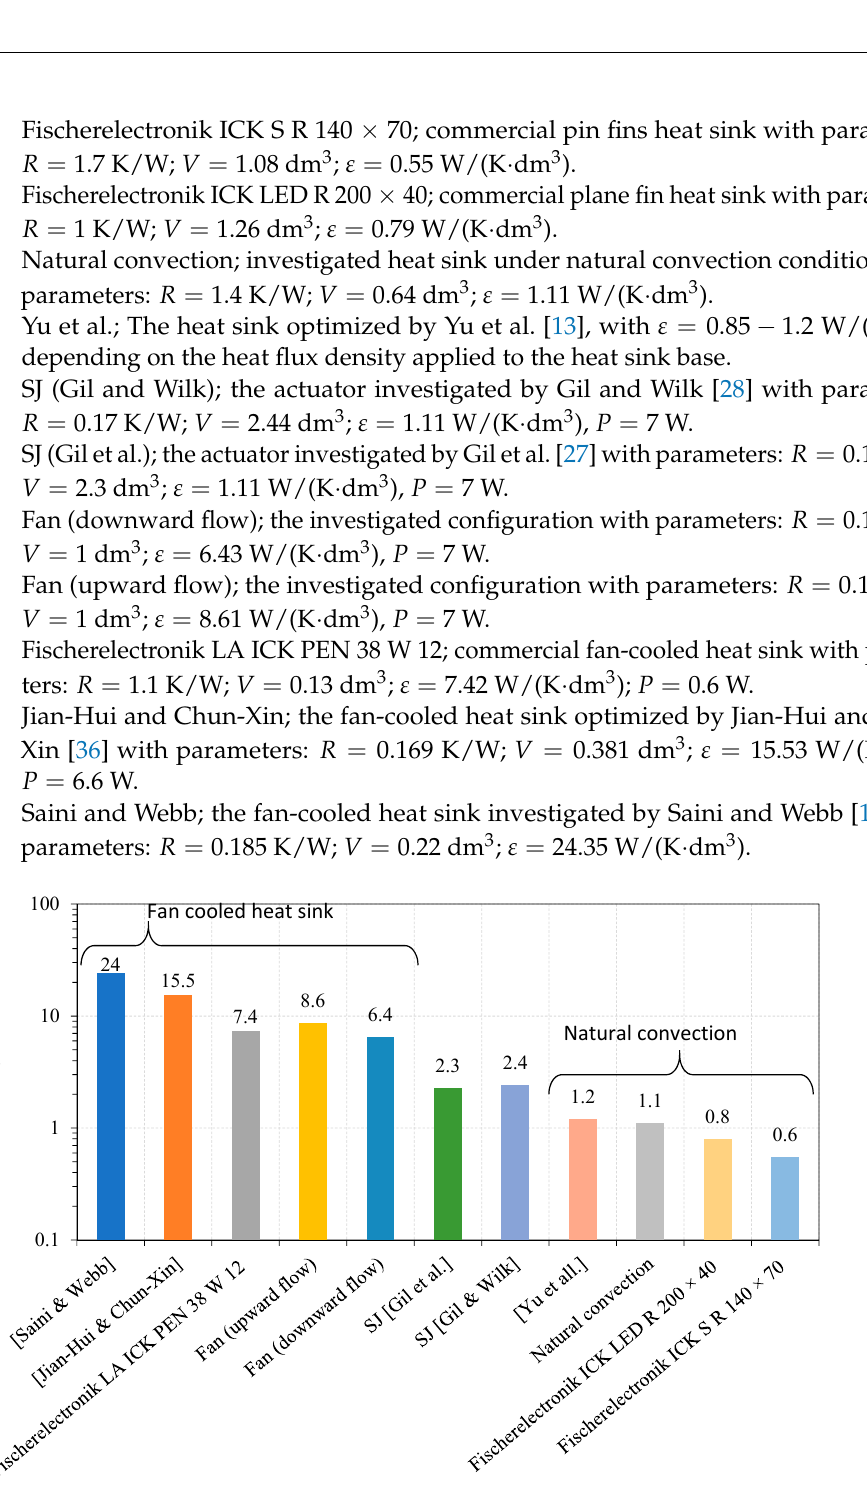
Figure 11. Comparison of the heat transfer rate of the heat sink per unit temperature difference and unit volume of the cooling device. Data from: Yu et al. [13], Gil et al. [27], Gil and Wilk [28], Jian-Hui and Chun-Xin [36], Saini and Webb [ Error! Reference source not found. ].{Formatting Citation}